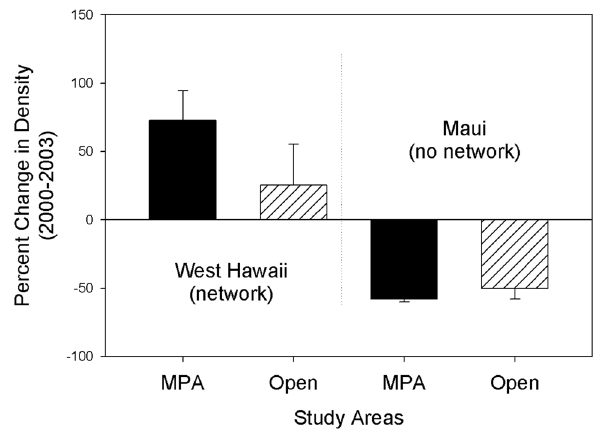
Figure 2. The mean percent change ( ± 1 SE) in density of yellow tang ( Zebrasoma flavescens ) before versus after MPA network establishment in West Hawai’i within limited-take and no-take MPAs and control (open to fishing) sites on West Hawai’i and Maui.